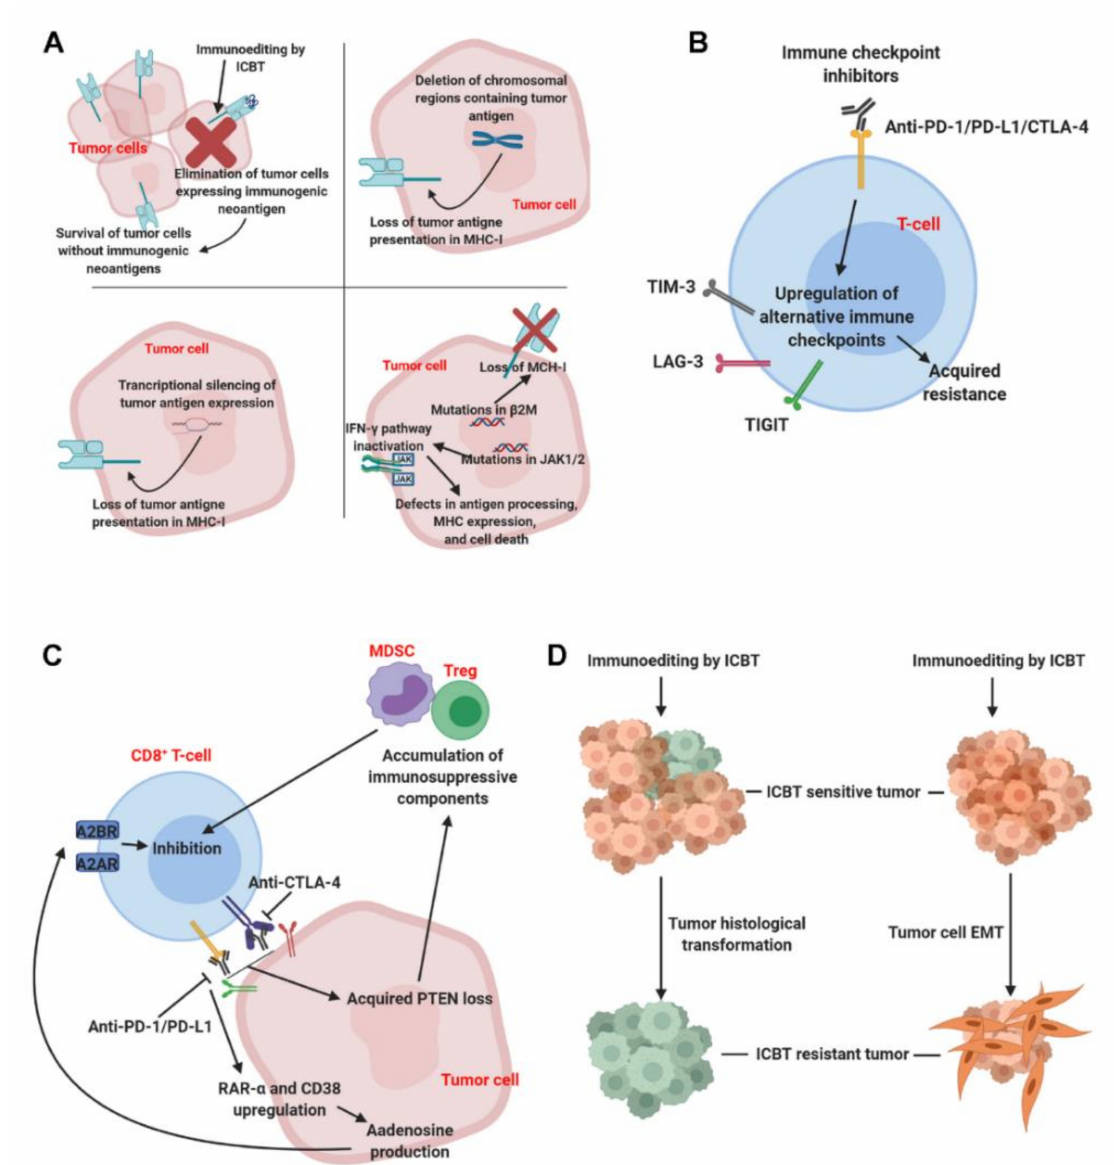
Figure 1. Overview of major mechanisms causing acquired resistance to immune checkpoint blockade therapy. Response to immune checkpoint blockade therapy (ICBT) is tightly controlled. The current literature has revealed several potential mechanisms contributing to acquired ICBT resistance. Panel ( A ), upper left: selective elimination of tumor cells with immunogenic neoantigens; upper right: loss of neoantigens due to chromosomal region deletion; lower left: loss of neoantigens due to transcriptional silencing; lower right: dysfunction of antigen processing and presentation. Panel ( B ): alternative immune checkpoints expression induced by ICBT. Panel ( C ): the coupling of tumor cell pathways stimulated by ICBT, such as adenosine production and PTEN loss, with the function of T cells. Panel ( D ): the transformation of tumor histological types and tumor cell epithelial–mesenchymal transition (EMT) after ICBT treatment. Abbreviations: MHC: major histocompatibility complex; PD-1: programmed cell death protein 1; PD-L1: programmed death-ligand 1; CTLA-4: cytotoxic T-lymphocyte-associated protein 4; TIM-3: T-cell immunoglobulin and mucin-domain containing-3; LAG-3: lymphocyte-activation gene 3; TIGIT: T-cell immunoreceptor with Ig and ITIM domains; MDSC: myeloid-derived suppressive cell; Treg: regulatory T-cell; A2AR: adenosine A2A receptor; A2BR: adenosine 2b